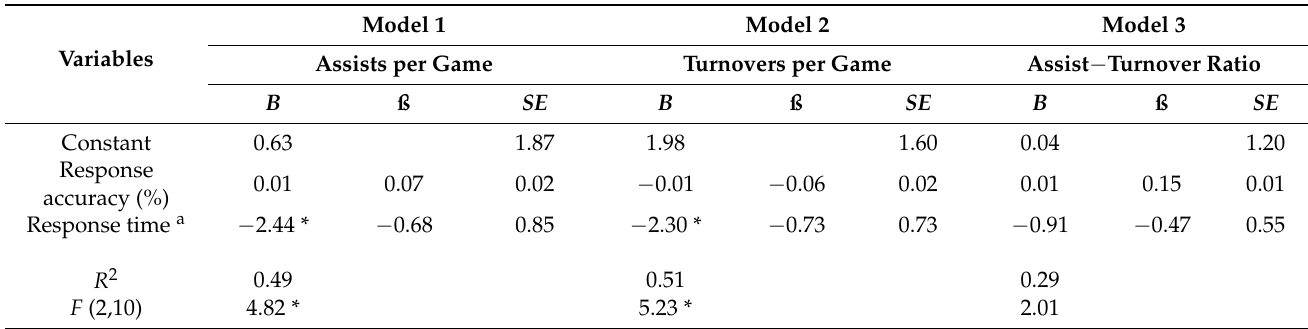
Table 4. Results of the multiple regression analysis for the determination of the relationship between the diagnostic results and the performance data.